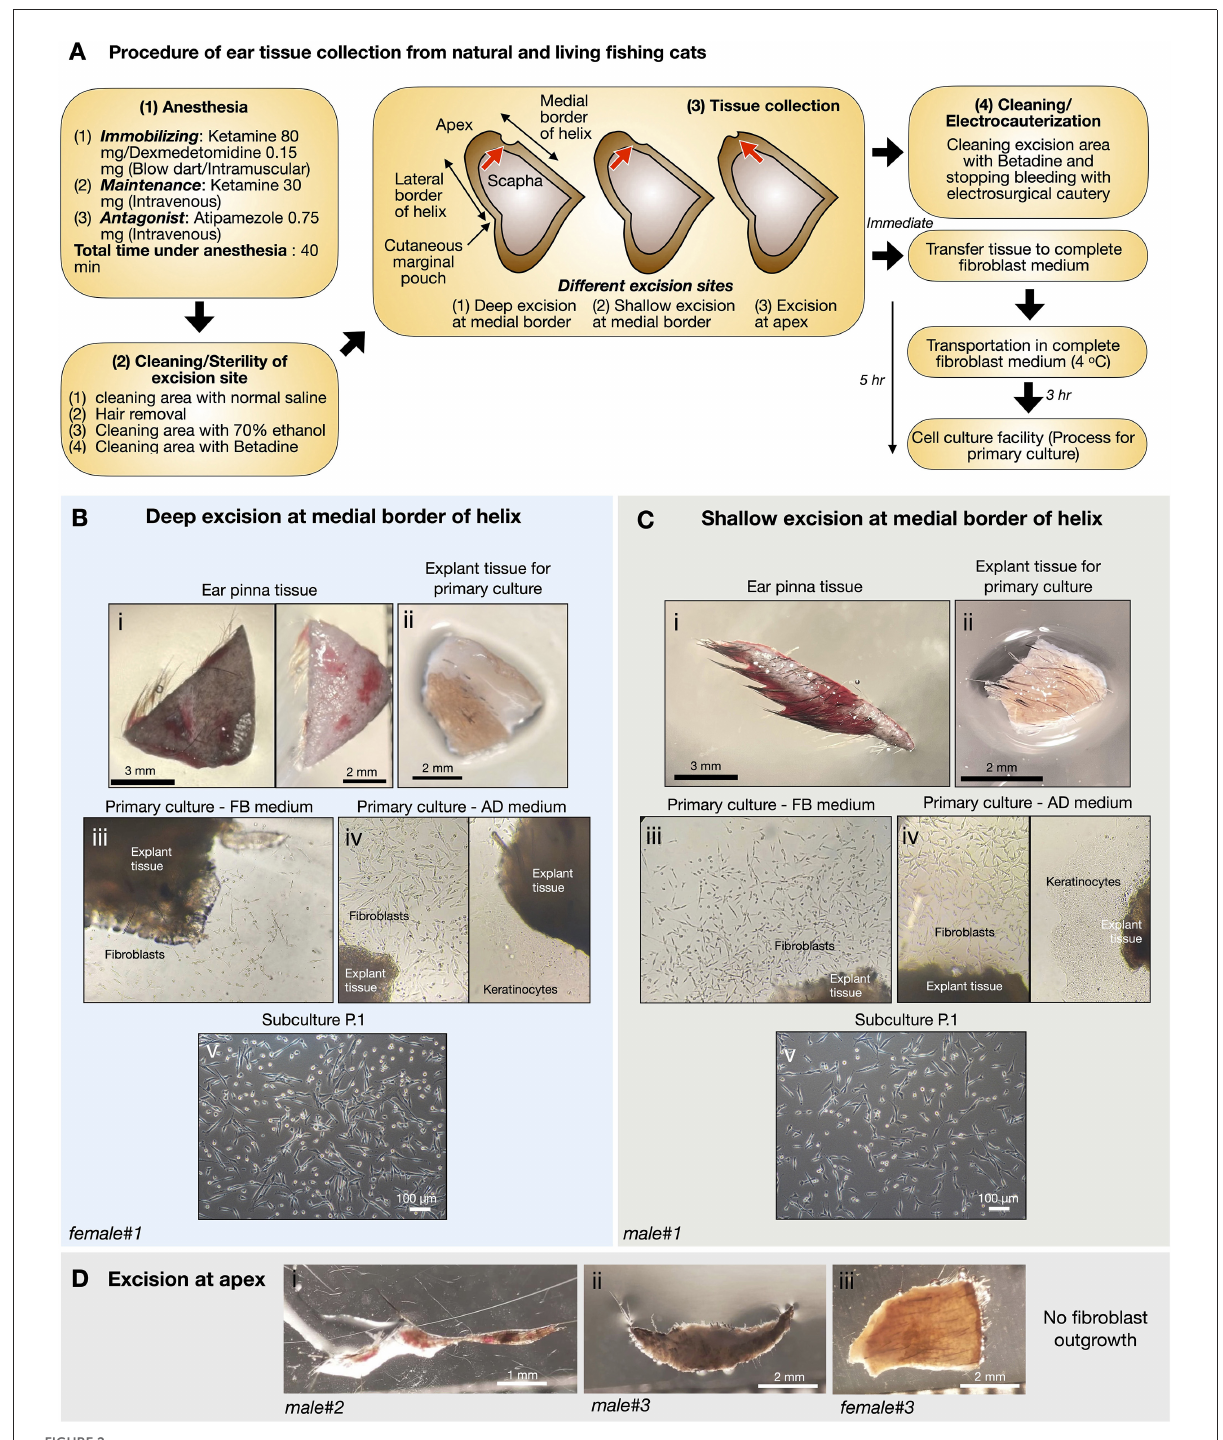
FIGURE2 Primary culture of fishing cat tissues collected from natural resources. (A) Procedure of ear tissue collection from natural and living fishing cats. (B,C) Tissues from excision at medial border of helix of ear pinna from female fishing cat (B) and male fishing cat (C) were collected and prepared for primary culture. The collected tissues (B i ,C i ) were washed and dissected into small pieces (explant) before seeding on gelatin-coated culture dishes (B ii ,C ii ) . The explants were cultured in complete fibroblast (FB) medium and advanced DMEM (AD) medium (B iii,iv ,C iii,iv ) . Fibroblast outgrowth was found in both FB (B iii ,C iii ) and AD medium (B iv left ,C iv left ) while keratinocyte outgrowth was observed only in AD medium (B iv right ,C iv right ) . (B v ,C v ) Subculture at passage 1 (P.1) after primary culture reaching 90% confluency. (D) Tissues from excision at apex of ear pinna from fishing